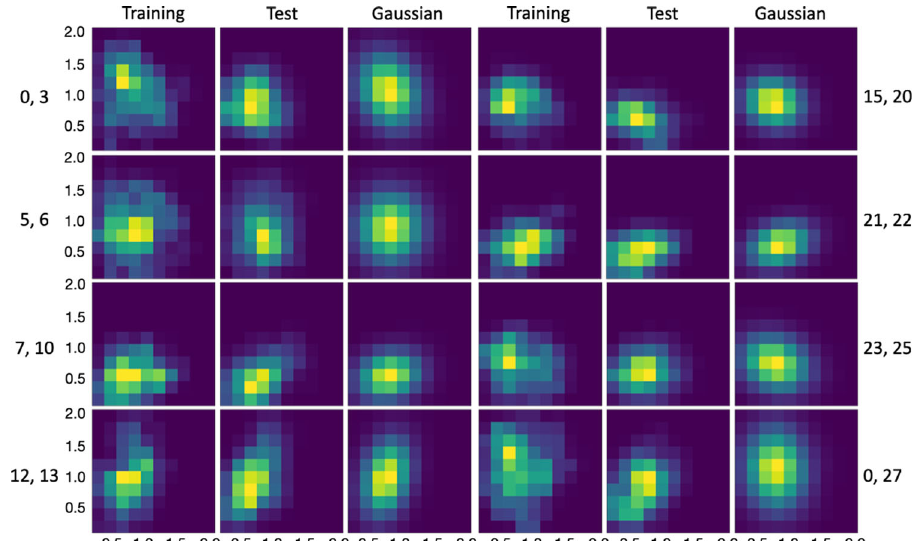
Fig. 3 Histograms of A β 40 in the latent space, calculated from training data, test data, and multivariate Gaussian. Histograms for pairs of encoder nonzero outputs from run1 are shown as heat maps, with yellow representing pixels with the highest counts and dark blue representing pixels with 0 count.